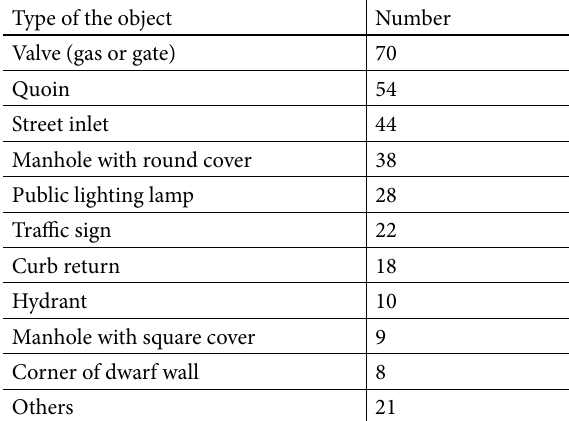
Table 2. Number of various types of surveyed objects in the Přívoz cadastral district